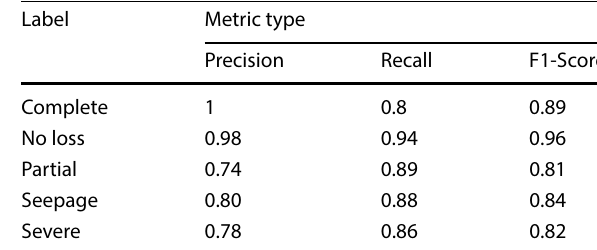
Table 7 Performance measurements achieved by the LSTM model for the testing subset of data records Label